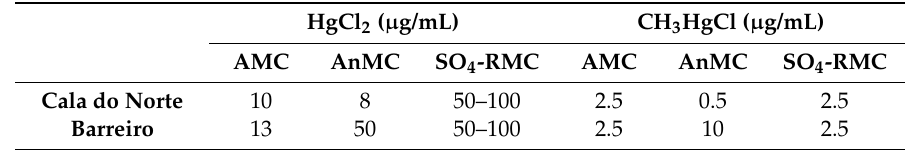
Table 1. Mercury (HgCl 2 and CH 3 HgCl) resistance levels of the microbial communities isolated from two mercury-contaminated areas of Tagus estuary—at Cala do Norte and Barreiro.